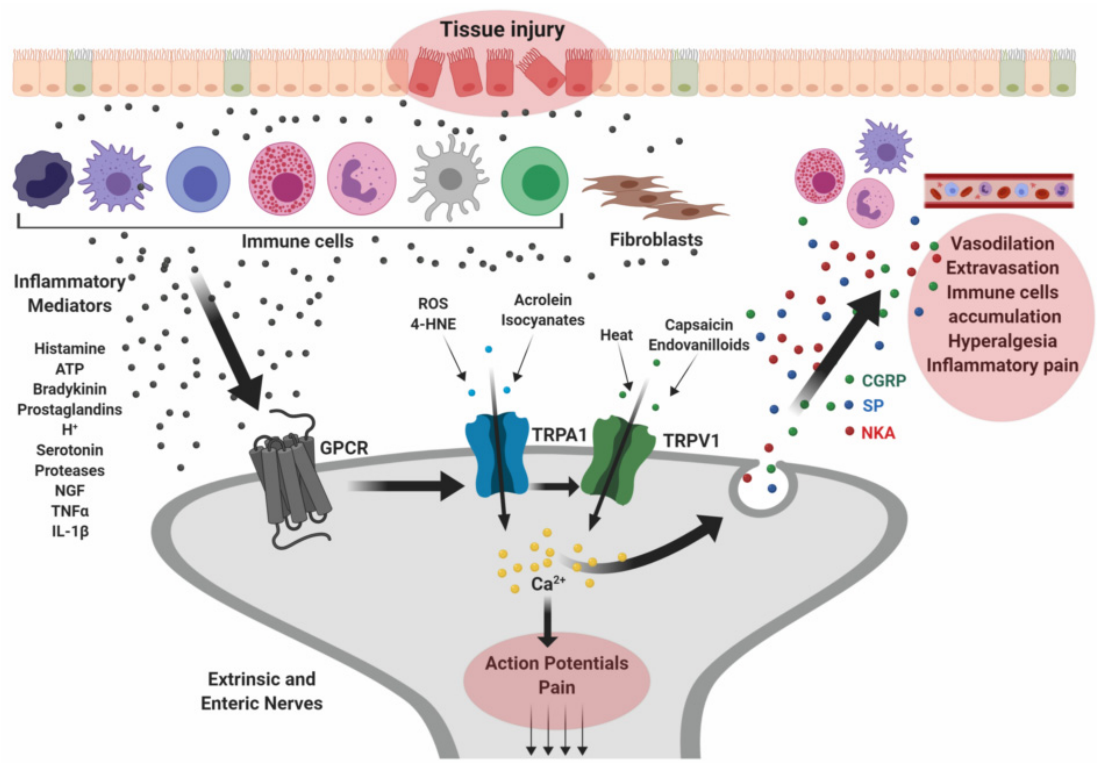
Figure 2. Implications of TRP in the pathophysiology of inflammatory bowel diseases. Tissue damage occurring along the GI mucosa may cause release of inflammatory mediators that activate principally immune cells and fibroblasts surrounding the injured tissue. These cells release more inflammatory molecules, including ATP, histamine, tumor necrosis factor α (TNF- α ), interleukin-1 β (IL-1 β ), nerve growth factor (NGF), and proteases, which bind specific G protein-coupled receptors (GPCRs) expressed in primary a ff erent sensory neurons. The consequent activation of TRP channels trigger the release of neuropeptides such as substance P (SP), calcitonin gene-related peptide (CGRP), and neurokinin A (NKA) which promote neutrophil accumulation, vasodilation, pain and other inflammatory responses. Created with